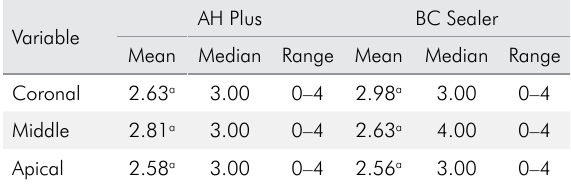
Table 1. Mean, median, and range of scores (0–4) obtained during analysis of filling of lateral canals, according to location in different radicular thirds (p =